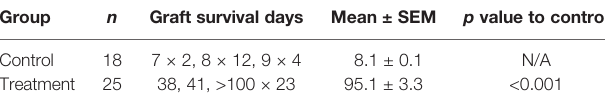
TABLE 1 | The mean survival time data from the mouse cardiac grafts experiments after treatment with the isotype control or FR70.